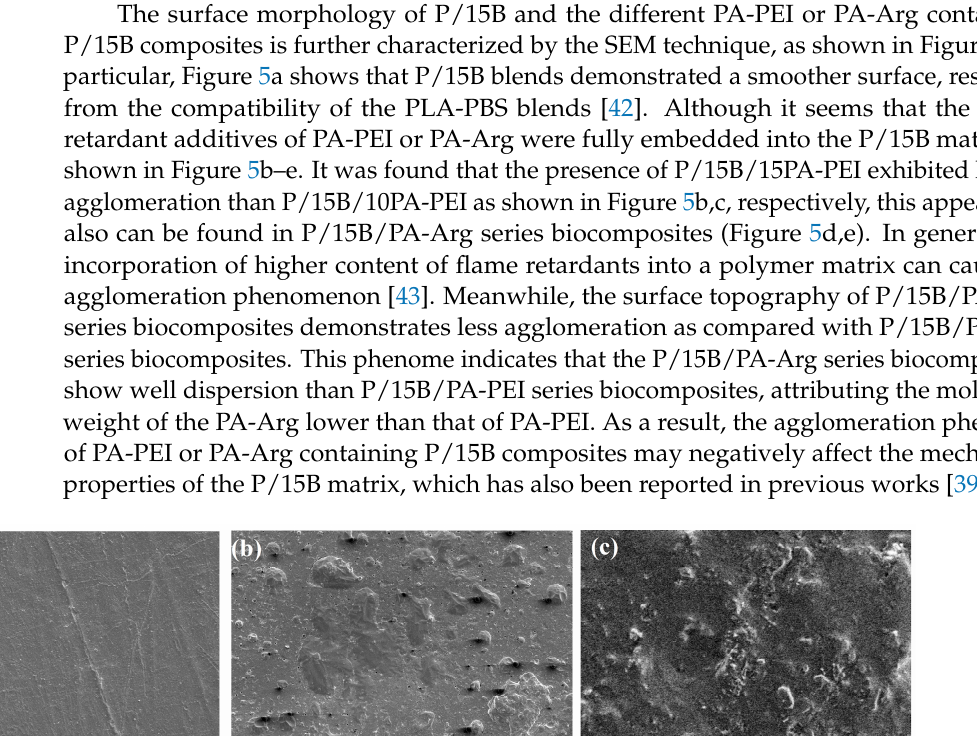
Figure 4. X-ray diffraction patterns of P/15B-based composites.